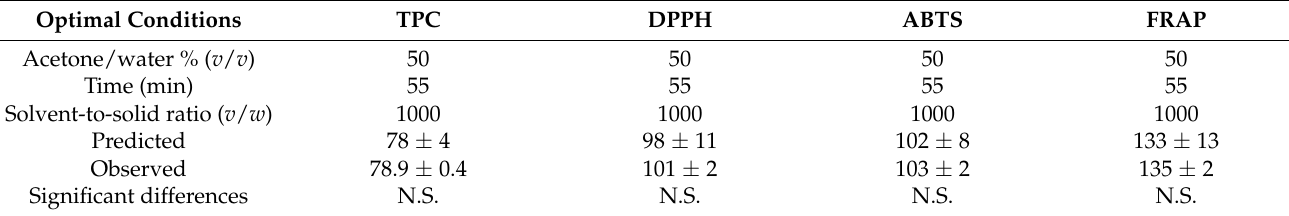
Table 3. Optimal conditions for UAE